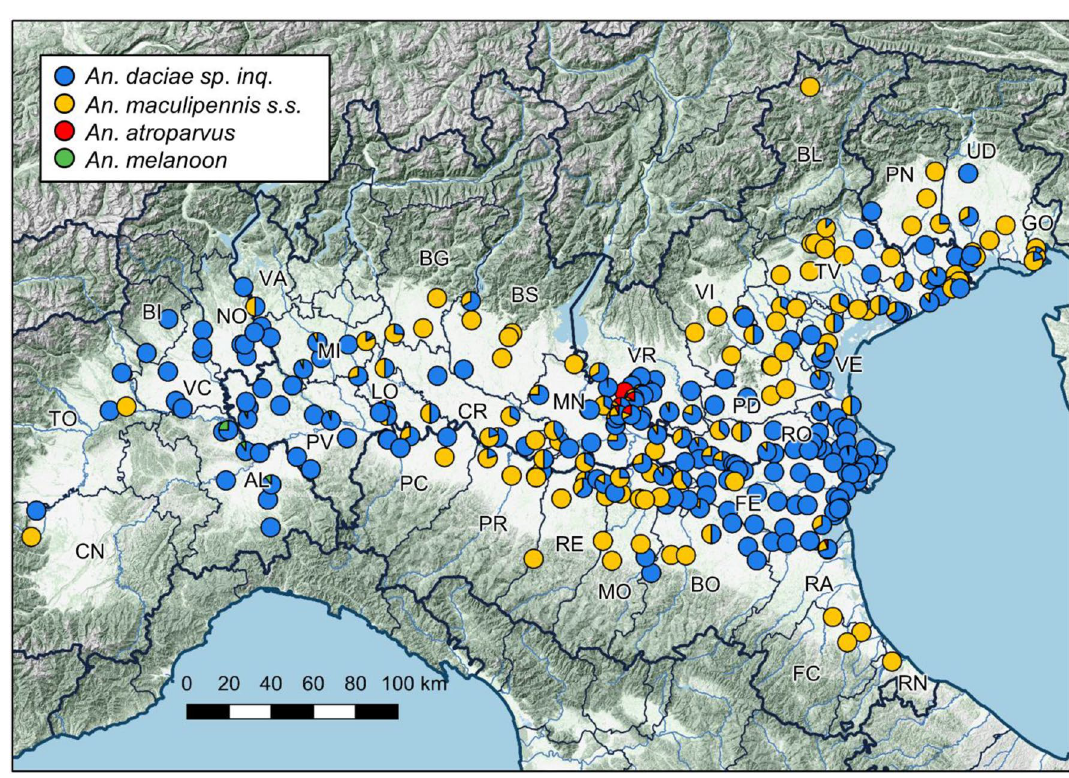
Figure 2. Proportion of different species identified in sampled sites. Abbreviations of Italian provinces (NUT3) with identified specimens are shown. The points of presence of every species are reported in Supplementary Figure S1. Map created using QGIS 3.10 (www. qgis. org); raster layers: Globe DEM (www. ngdc. noaa. gov), EU-Hydro (www. coper nicus. eu).